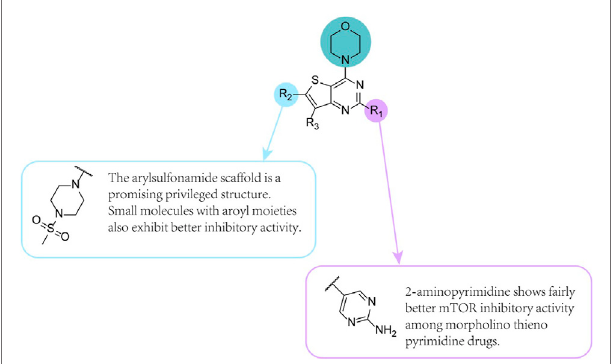
FIGURE 4 | SAR of thienopyrimidine core compounds.